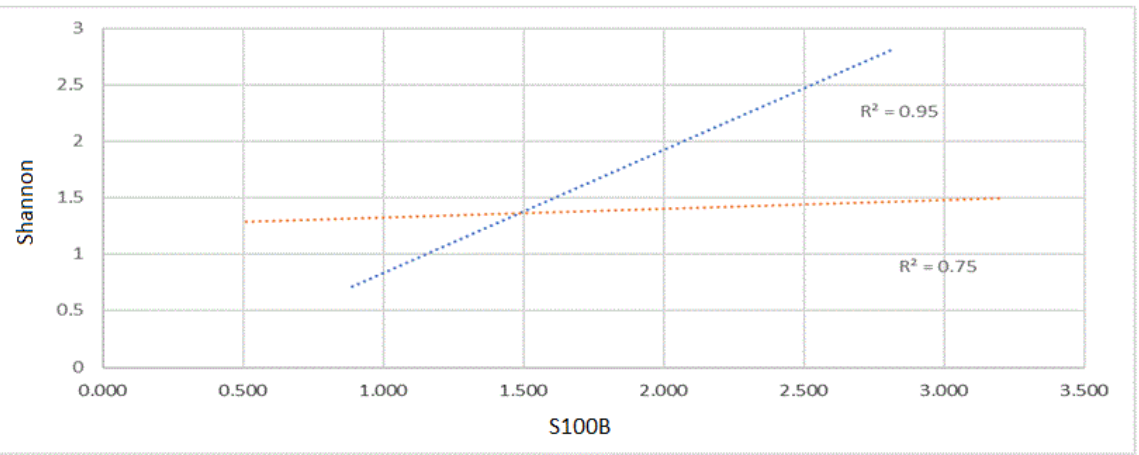
Figure 2. Relationship between S100B concentration and Shannon index in mice treated ( n = 25) with PTM (red line) and without (n = 28) PTM treatment (blue line). The diagram shows a positive correlation between S100B concentration (ng/mL) and Shannon values without treatment (R 2 = 0.95) that is reduced after PTM treatment (R 2 = 0.75).